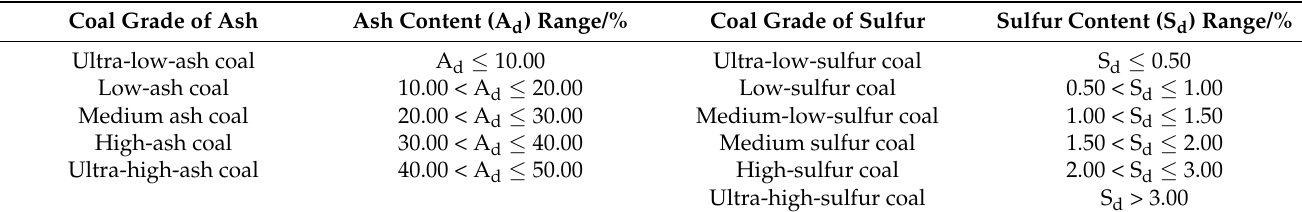
Table 2. Classification categories of ash and sulfur of coal in China